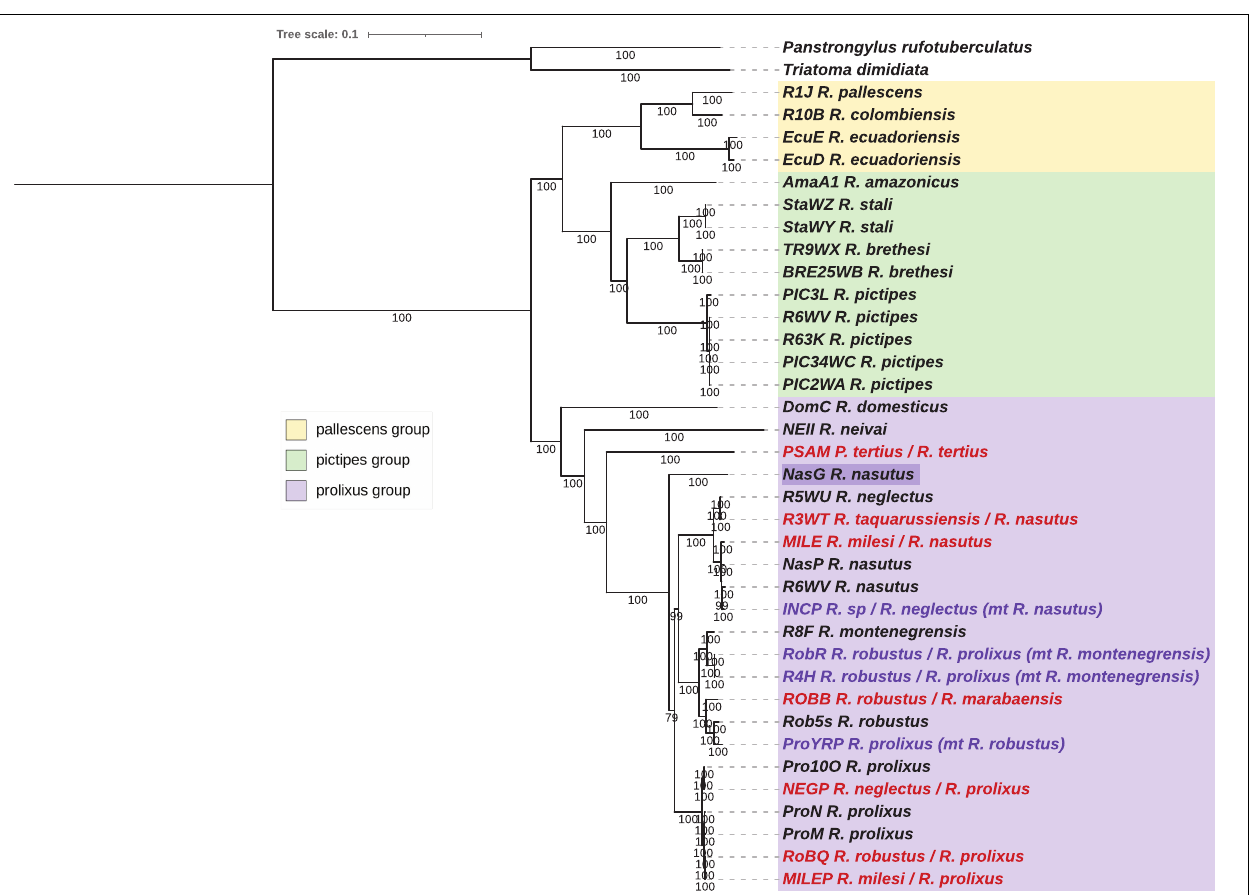
clade as the laboratory reference R5WU R. nasutus